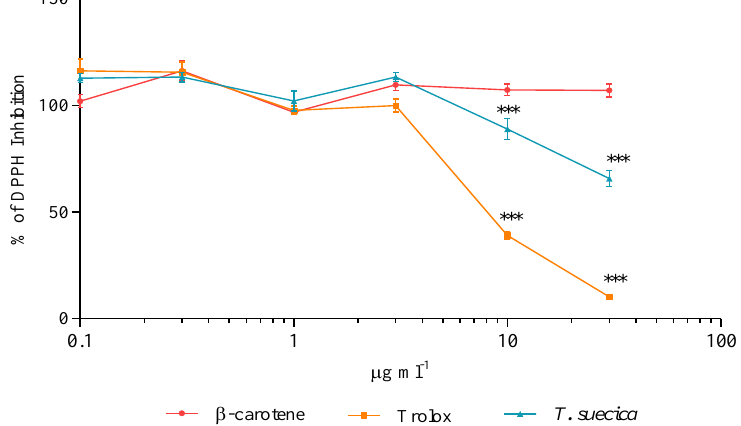
Figure 6. Radical scavenging capacity of β-carotene, Trolox and Tetraselmis suecica extract (0.1, 0.3, 1, 3, 10 and 30 µg mL −1 ) on DPPH free radical. Values are expressed as the mean ± SD of the percentage of DPPH inhibition. Asterisks indicate statistically significant differences compared to negative control (*** p ≤ 0.001; Dunnett’s test).